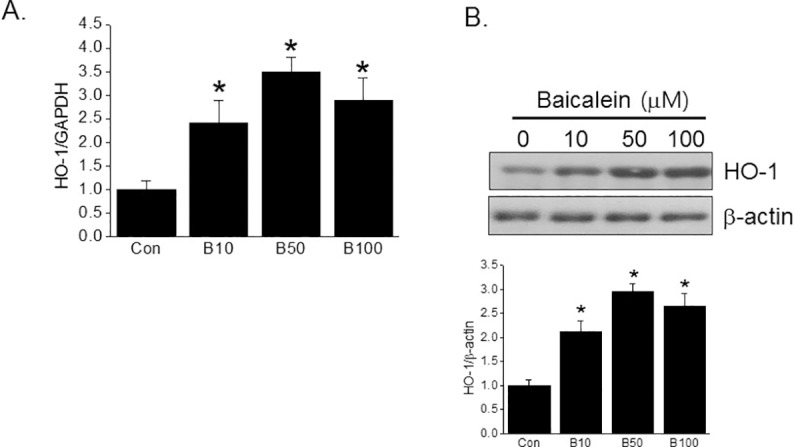
Effects of baicalein on HO-1 expression.INS-1 cells were treated with different concentrations of baicalein (0–100 μM) for 11 h (A, for qPCR) or 27 h (B, for western blot). HO-1 mRNA expression and protein levels were assessed by qPCR or western blotting, respectively. The results shown are representative of three independent experiments and are expressed as means ± SDs. *P<0.05 vs. controls.